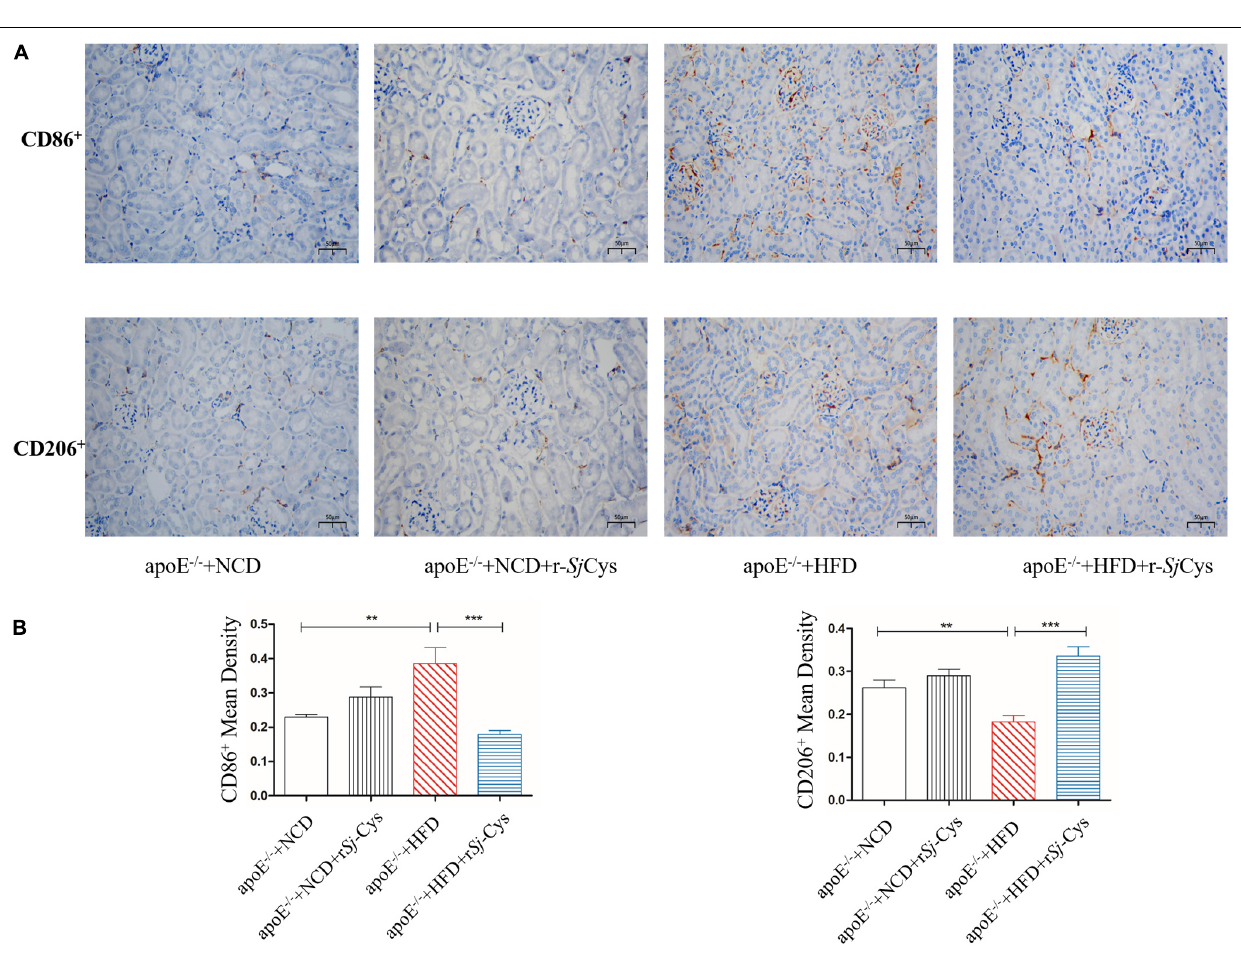
Frontiers in Cell and Developmental Biology |